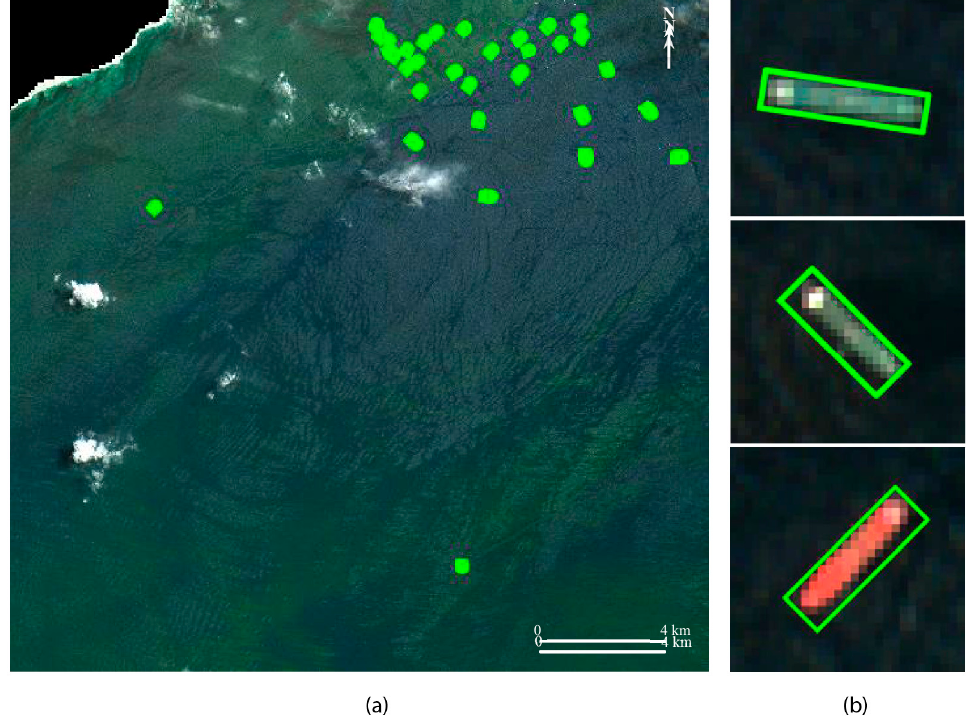
Figure 10. Automatic vessel detection in Sentinel-2 MSI data: ( a ) RGB image with detected vessels shown in green; ( b ) estimated dimensions and orientation are illustrated with rectangles.